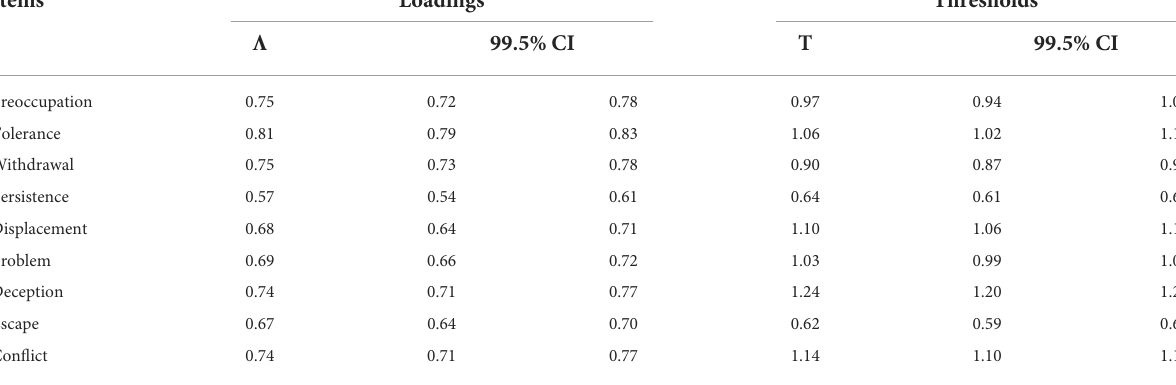
TABLE 2 CFA model of the Social Media Disorder Scale: item loadings and